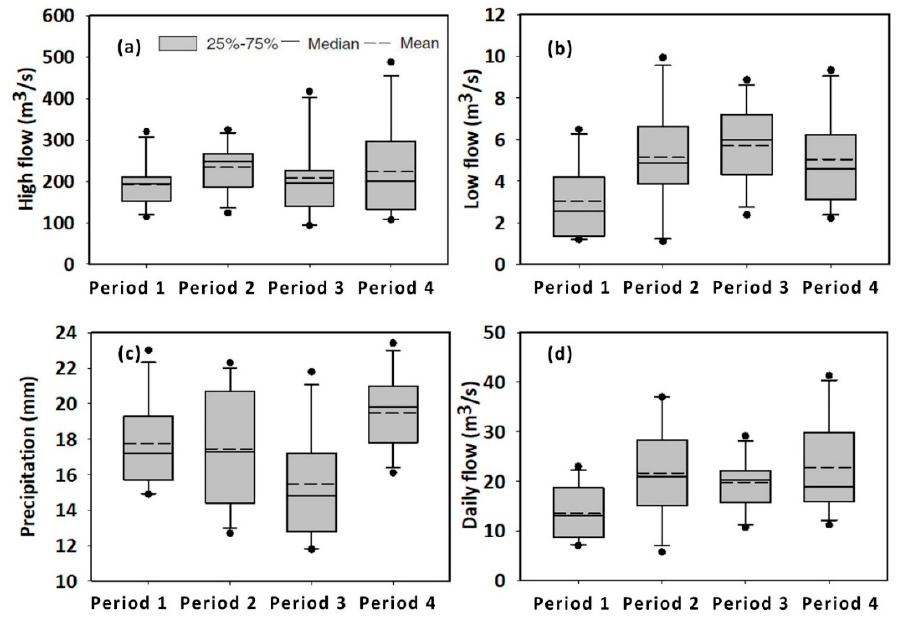
Figure 6. The magnitude of high flows (flow exceedance of 5%) in four periods ( a ); The magnitude of low flows (70% exceedance) in four periods ( b ); The precipitation exceeded at 10% ( c ); The daily flow exceeded 50% of the time in a given year ( d ). Period 1 = 1972–1982, Period 2 = 1984–1994, Period 3 = 1995–2005, Period 4 = 2006–2016.